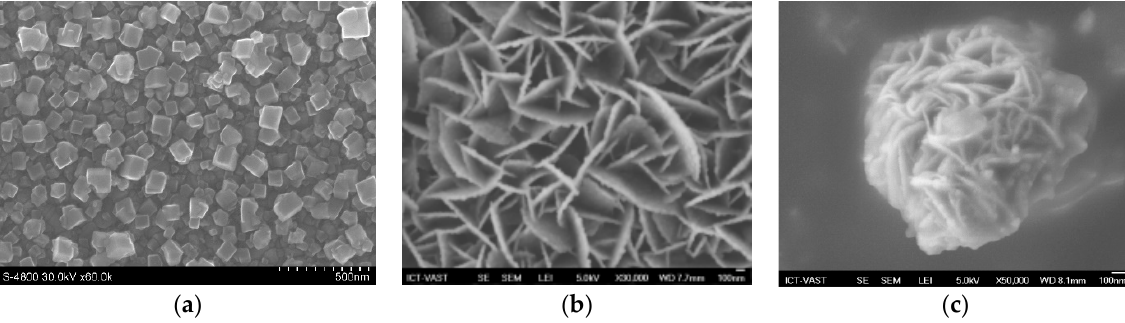
Figure 8. FE-SEM images of counter electrodes based on different materials: ( a ) PbS, ( b ) CuS, and ( c ) Cu 2 S from Tung HT and co-works, 2014 [129].